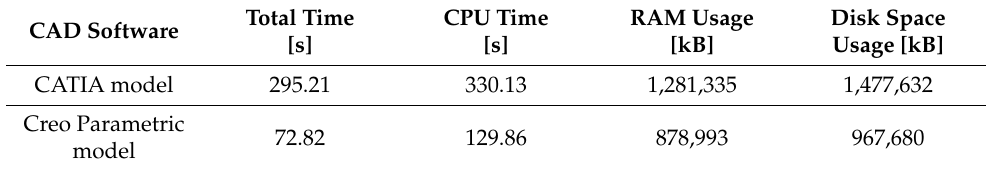
Table 2. Computation time of the FE analyses.